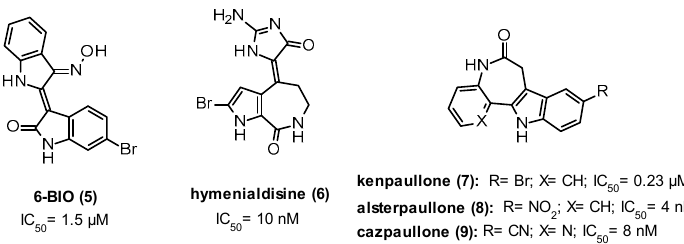
Figure 7. Different chemical classes of ATP-competitive GSK-3 β inhibitors endowed with promising CNS preclinical potential.